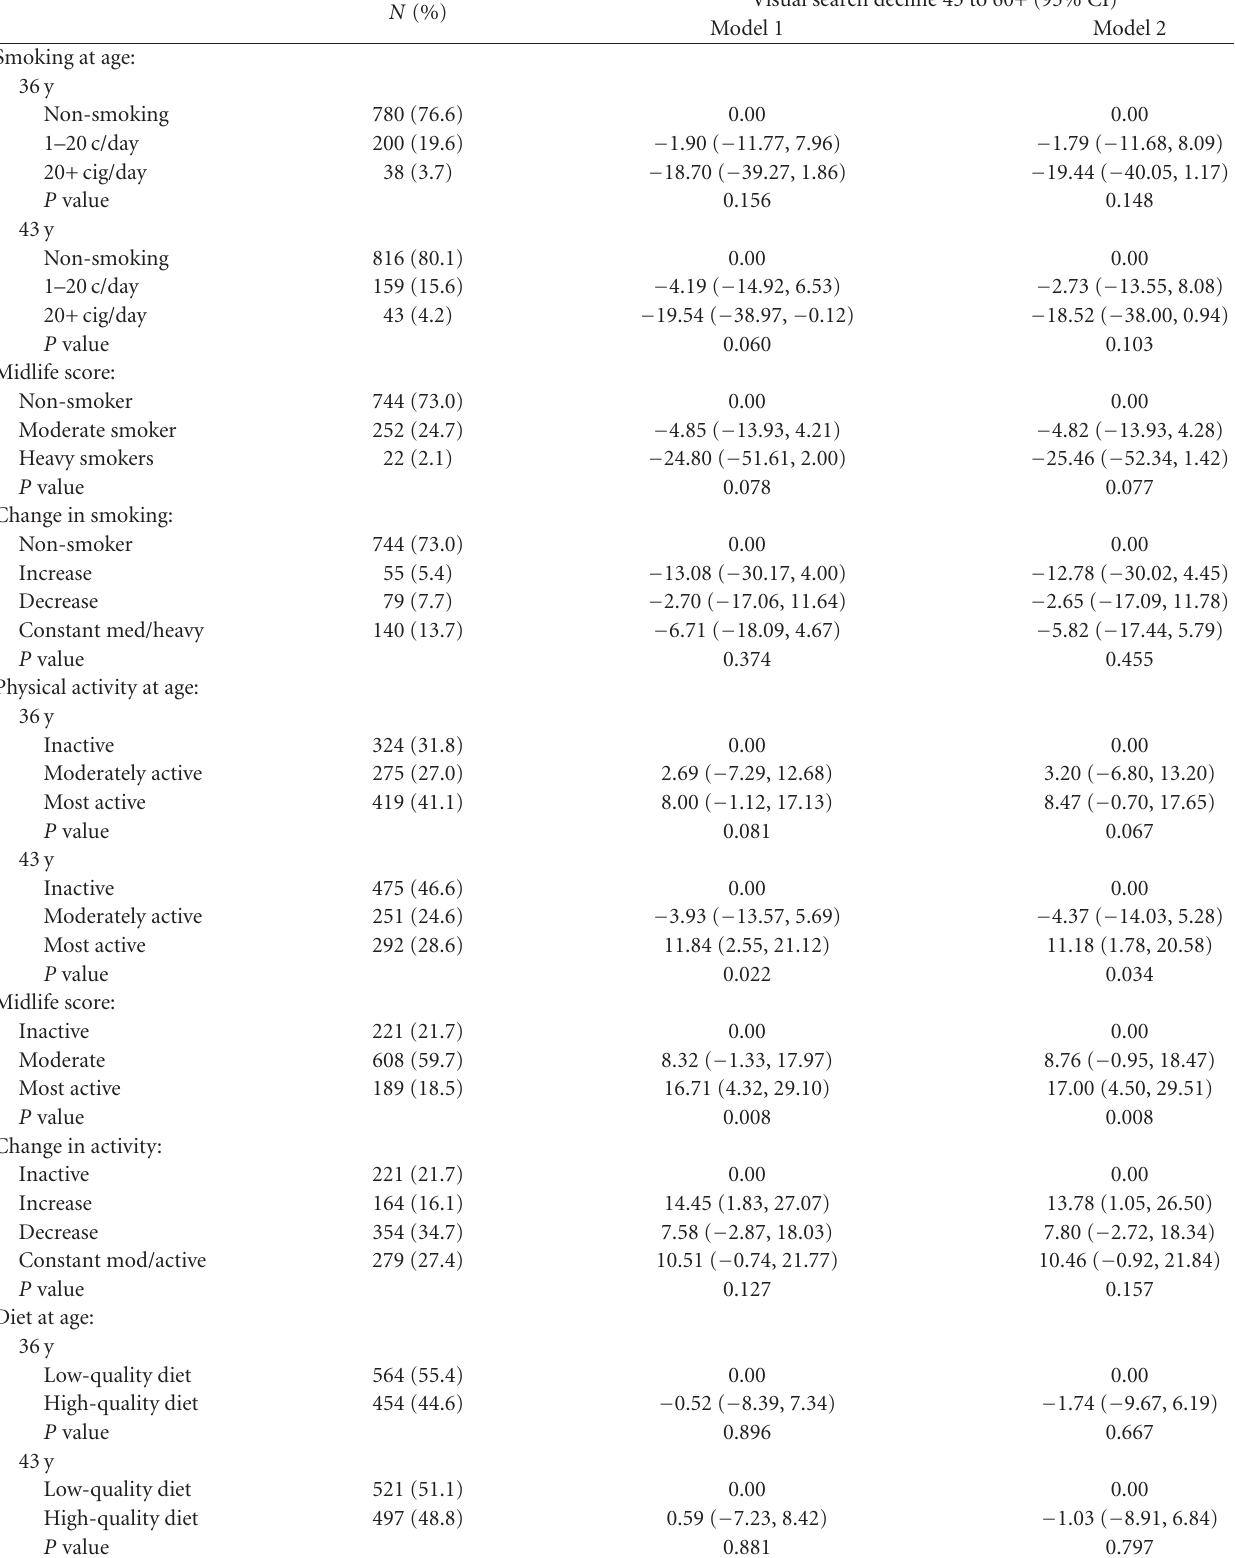
Table 3: Regression coe ffi cients (95% confidence intervals) representing rate of decline in visual search from 43 to 60+ years per level increase in each health behavior at 36 and 43 years and per cumulative and change in health behavior scores. N (%) Visual search decline 43 to 60+ (95% CI) Model 1 Model